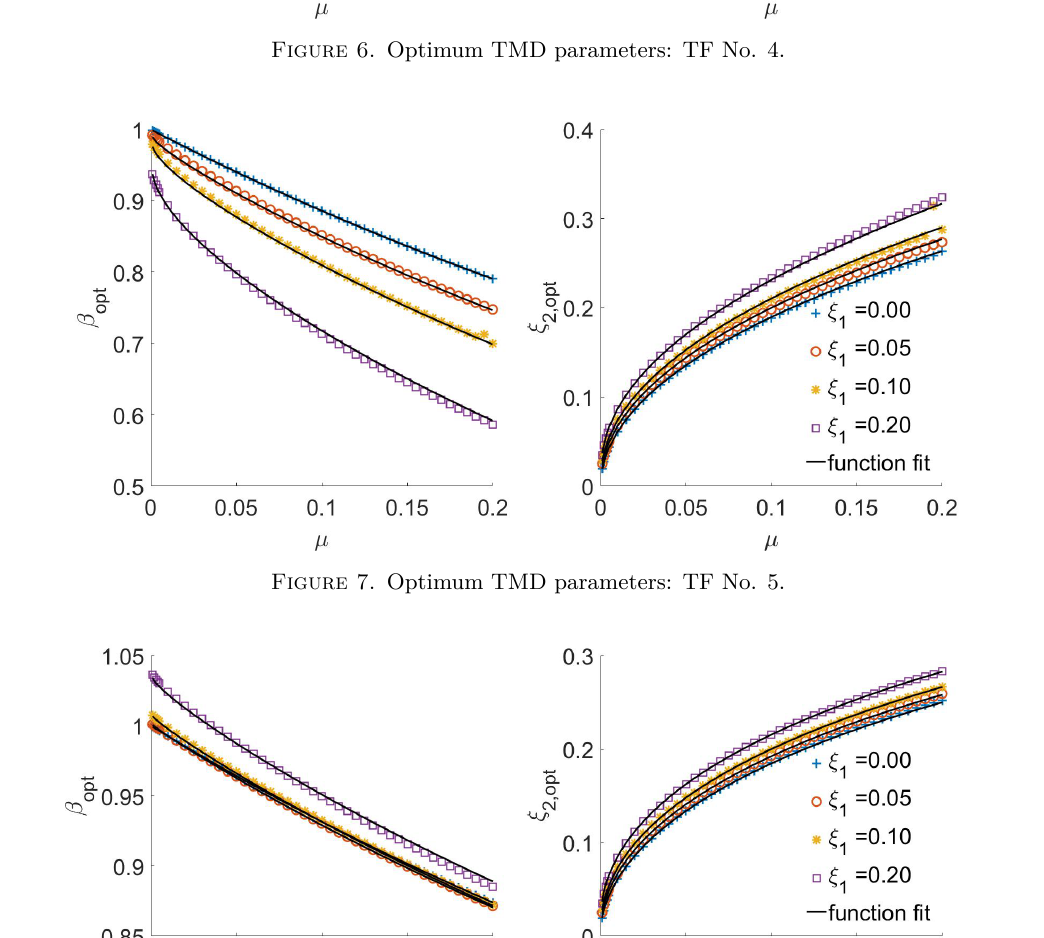
Figure 6. Optimum TMD parameters: TF No. 4.